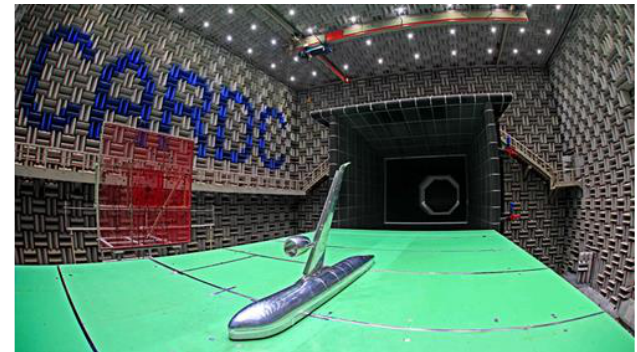
Figure 5. The CARDC FL-17 aeroacoustics wind tunnel.